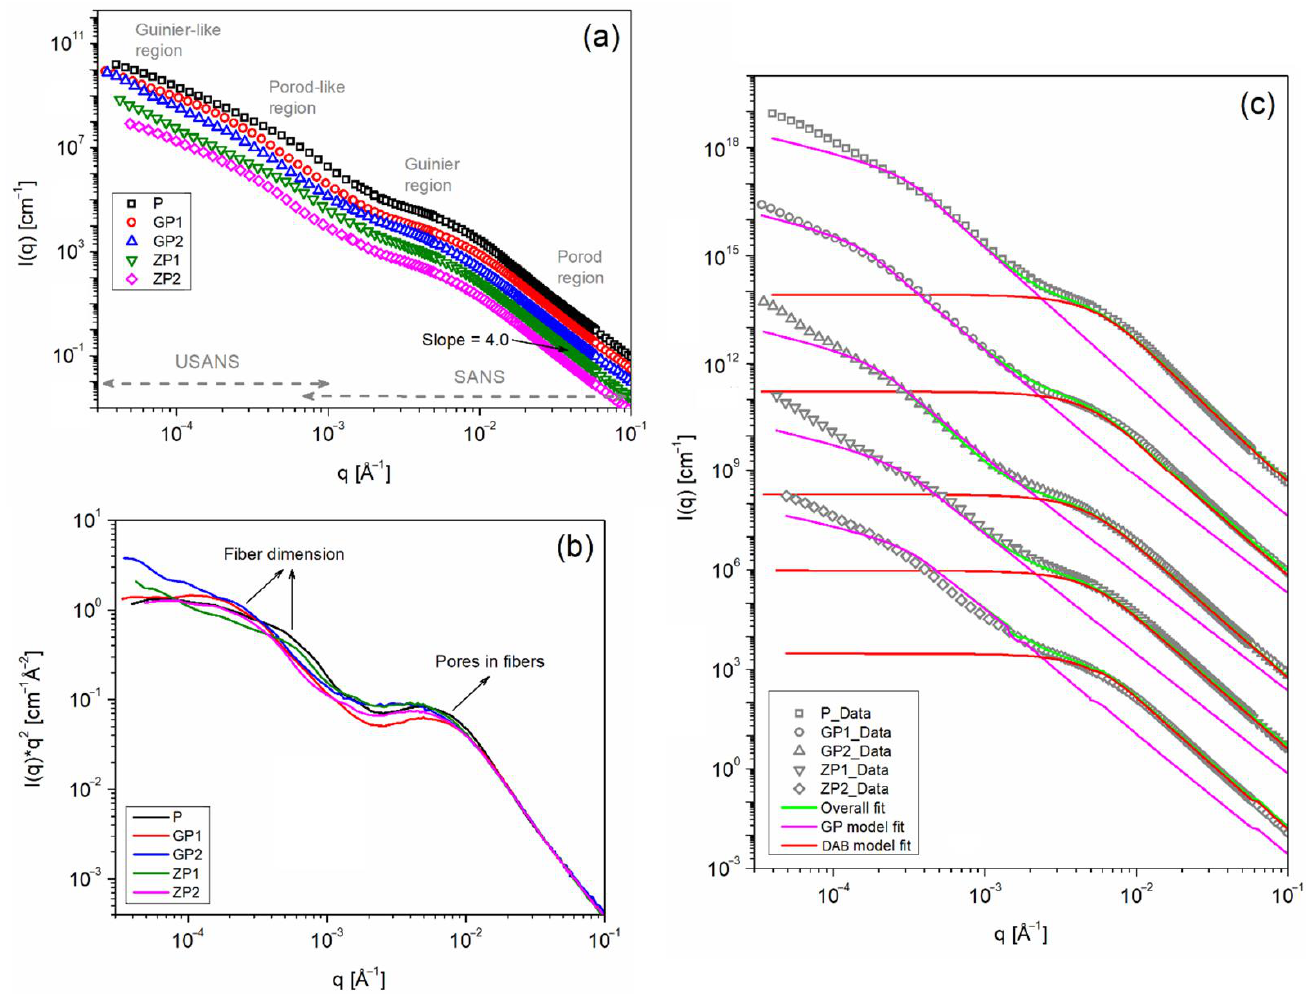
Figure 3. ( a ) Combined SANS and USANS intensity profile and ( b ) Kratky plot of the five membranes. ( c ) Model function fits. The intensity in graph ( a , c ) are offset for clarity. A combined form factor model function, i.e., shape-independent Debye-Anderson- Brumberger model (high-q to mid-q) + Guinier-Porod model (mid-q to low-q) was used 3c shows the model fit results. The Debye-Anderson-Brumberger (DAB) model describes